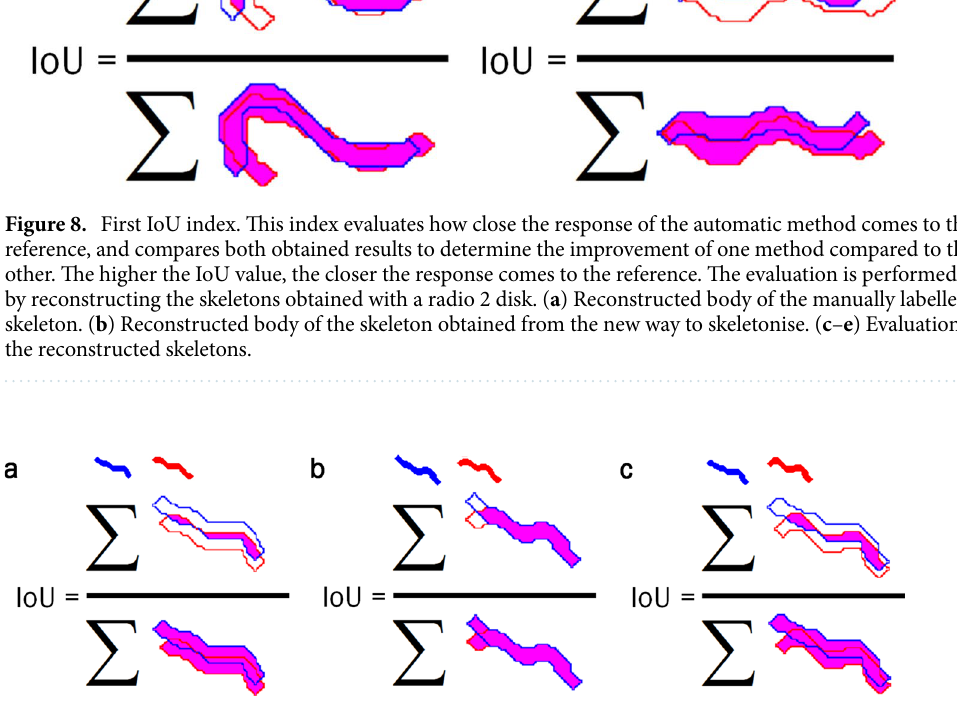
Figure 9. Second IoU index. This index measures how connected two resulting bodies are to one another. The lower the IoU value, the further apart bodies are. Like the earlier method, the evaluation is performed by reconstructing the skeletons obtained with a radio 2 disk. ( a ) Reconstructed bodies from the manually labelled skeletons. ( b ) Reconstructed bodies from the skeletons obtained with the classic method. ( c ) Reconstructed bodies from the skeletons obtained by the proposed